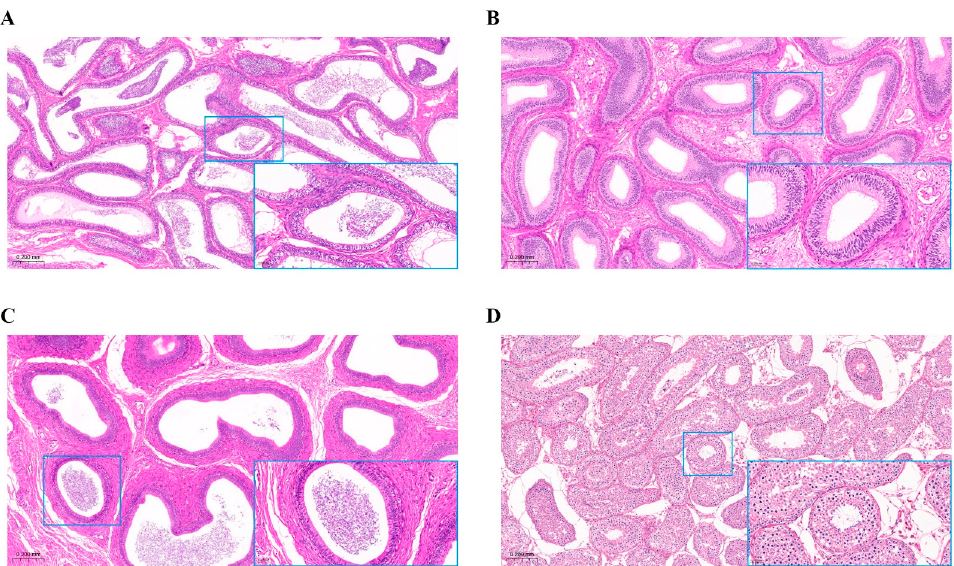
Figure 1. Histological observation of epididymis and testis. ( A ) Epididymis caput. ( B ) Epididymis corpus. ( C ) Epididymis cauda. ( D ) Testicular tissue. The blue box shows a partial enlarged (40 × ) view of the organization.